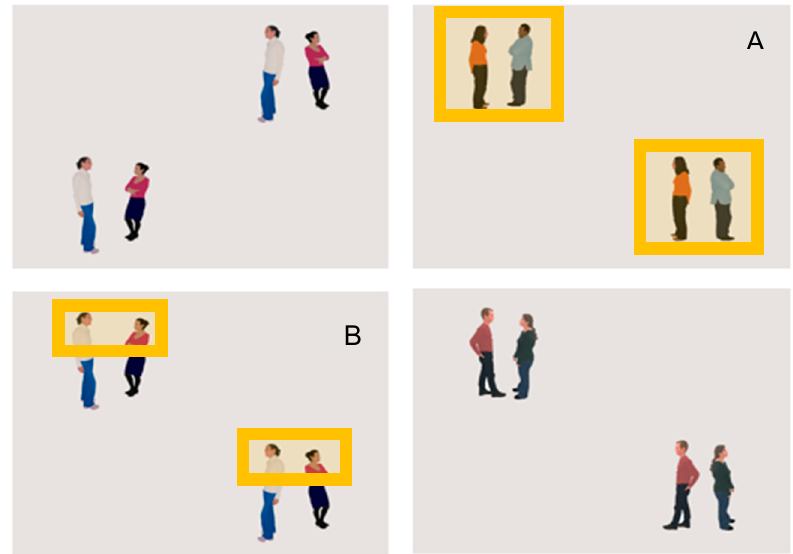
Figure 1. Example of the stimuli presented with example AOIs by a yellow outline. Box A shows an example of generated whole figure interacting and non-interacting AOIs in a single trial. Box B shows an example of the head-only interacting and non-interacting AOIs in a single trial.